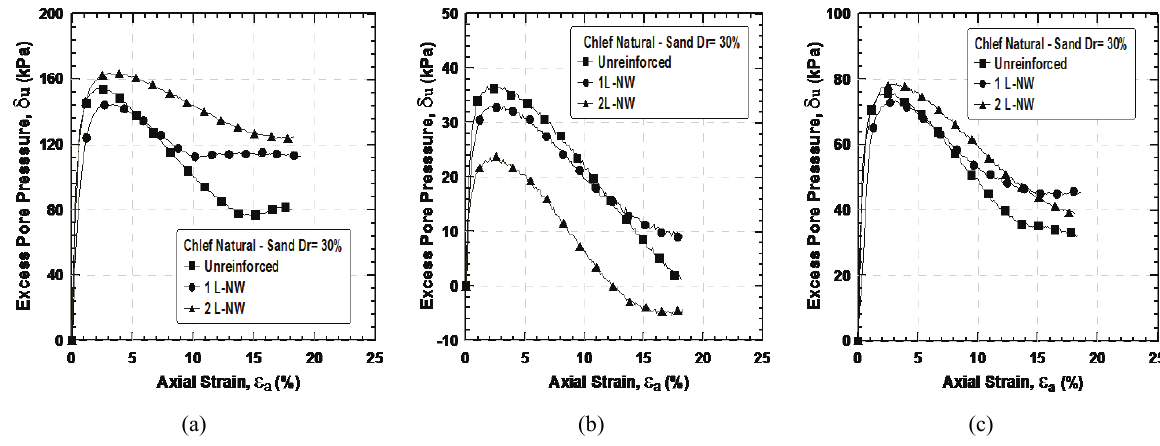
Fig. 9. Excess pore water pressure versus axial strain curves of sand reinforced with various number of geotextile layers under different confining pressures: (a)